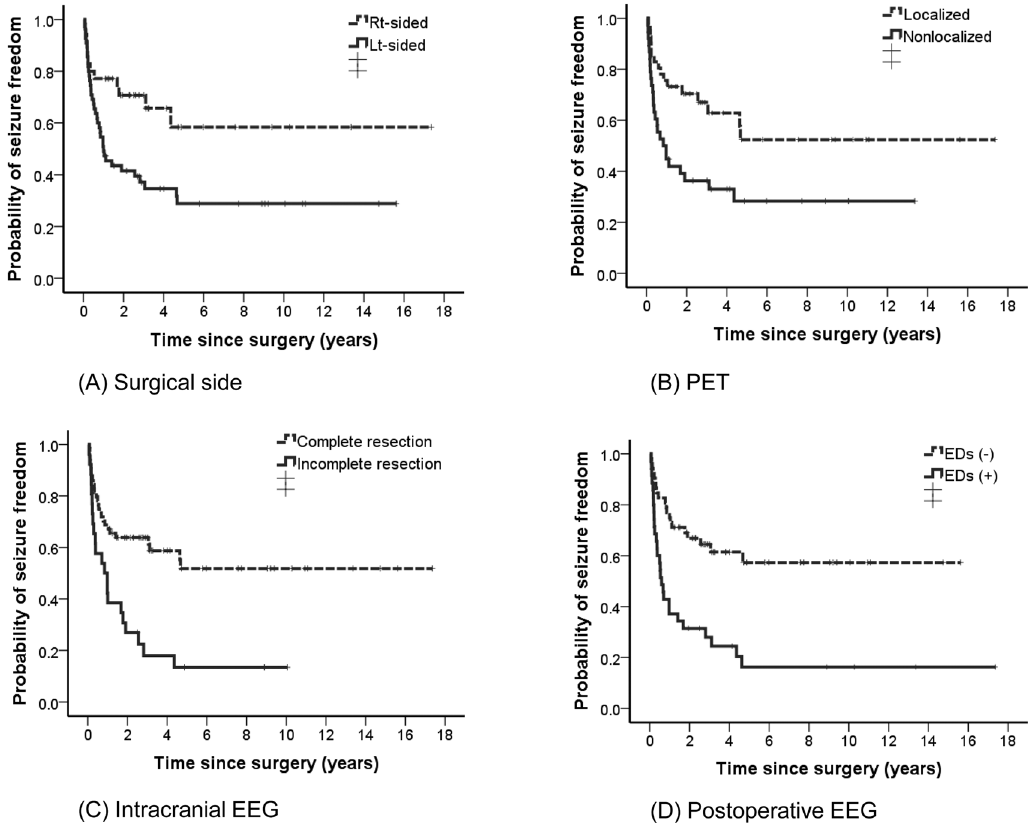
Fig 2. A Kaplan-Meier survival plots for groups with and without each predictor (A-D) from surgery to seizure recurrence. In the last year of follow- up, left-sided resection, non-localized PET, and incomplete resection were associated with recurrent seizures. PET, positron emission tomography; EEG, electroencephalography